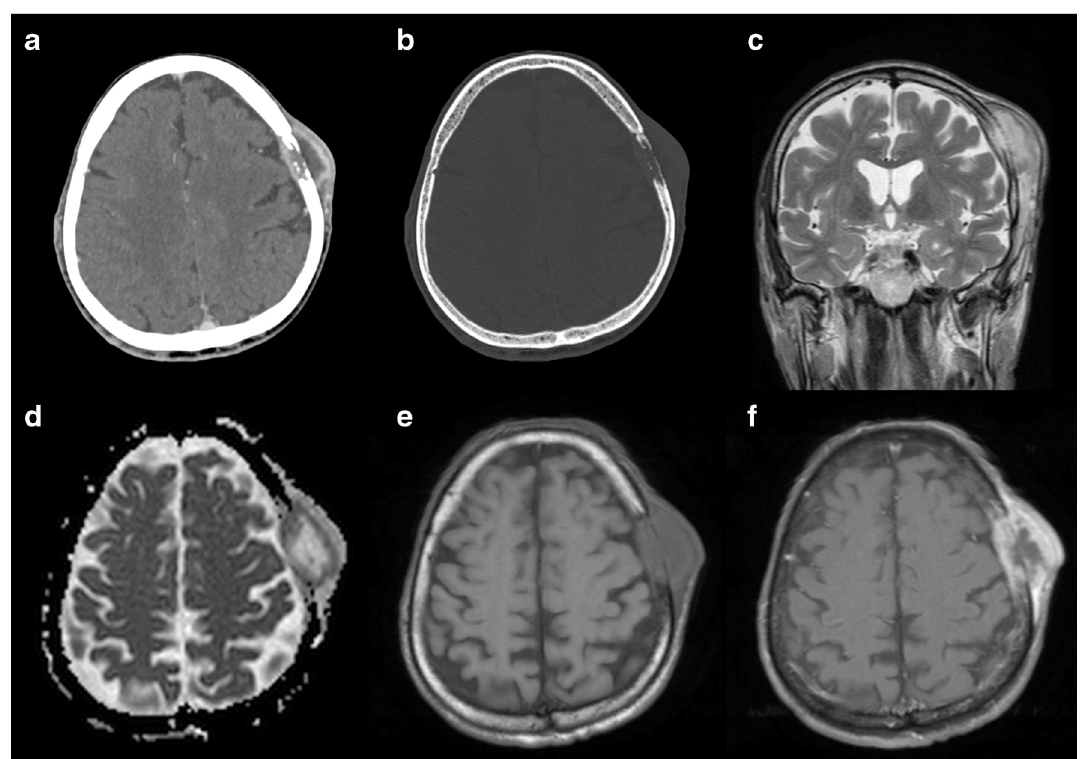
Fig. 14 Metastasis. Axial contrast-enhanced CT, with brain ( a ) and bone ( b ) windows showing a left parietal lytic, widely necrotic, lesion with intra- and extracranial extension. MRI better depicts extraosseous spread on both intra- and extracranial aspects, with dural displacement and